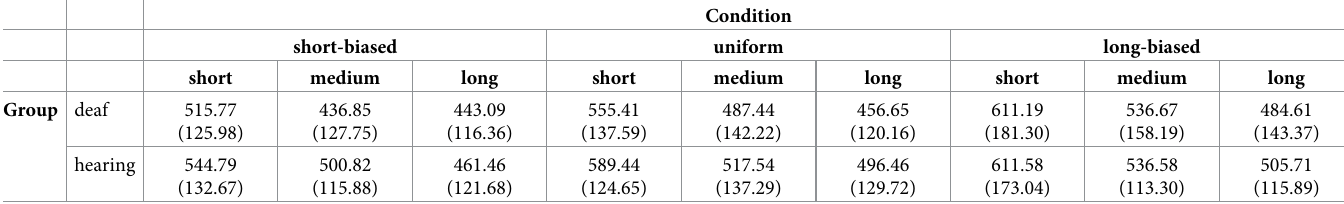
Table 5. Means and standard deviations for reaction times